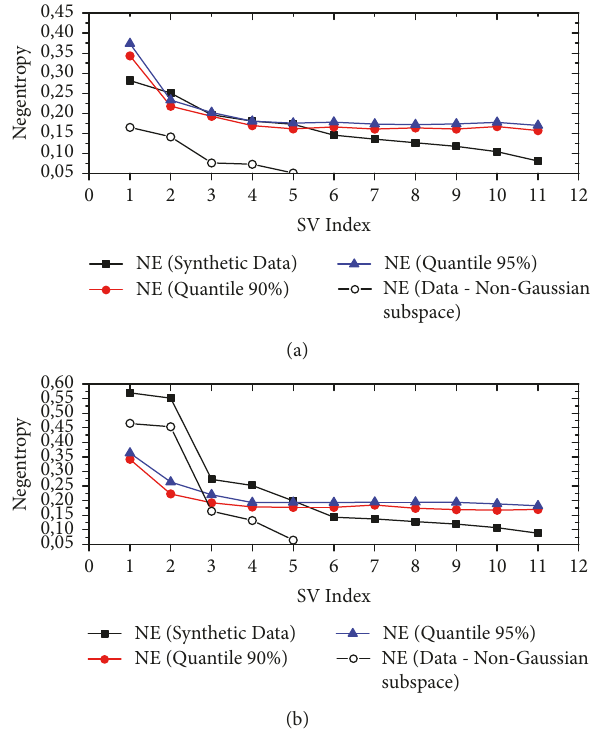
Figure 8: Same as Figure 6 but for the for synthetic data with 𝜎 2 = 20 % (a) and 𝜎 2 = 40 %